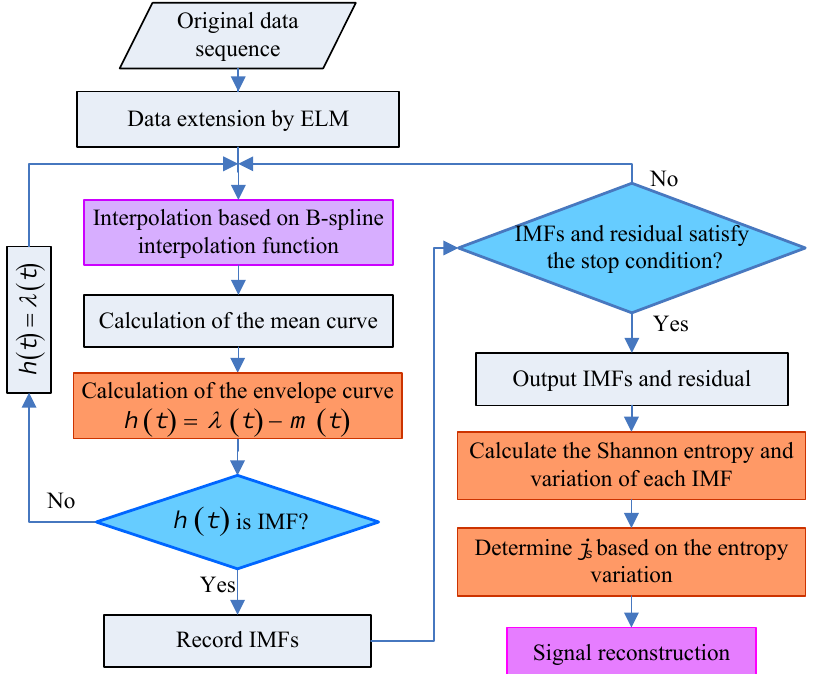
Figure 2. The process of IMU signal denoising based on